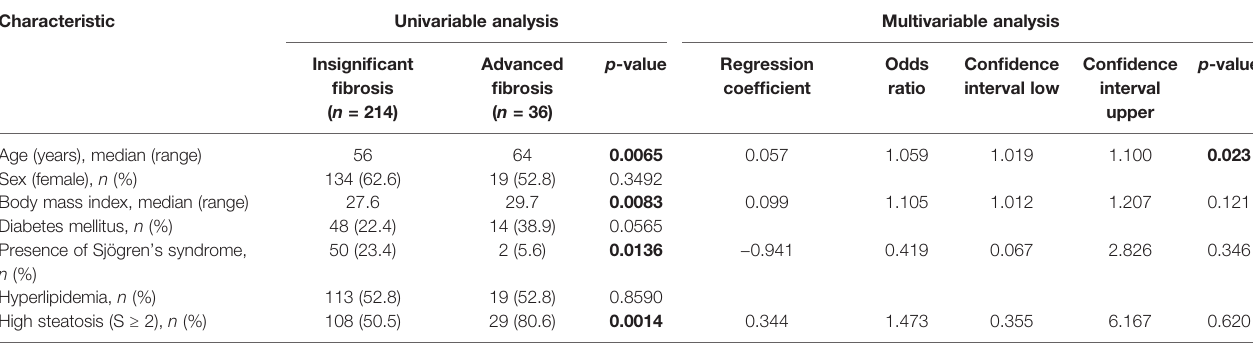
TABLE 2 | Comparison between study participants with low and high liver fi